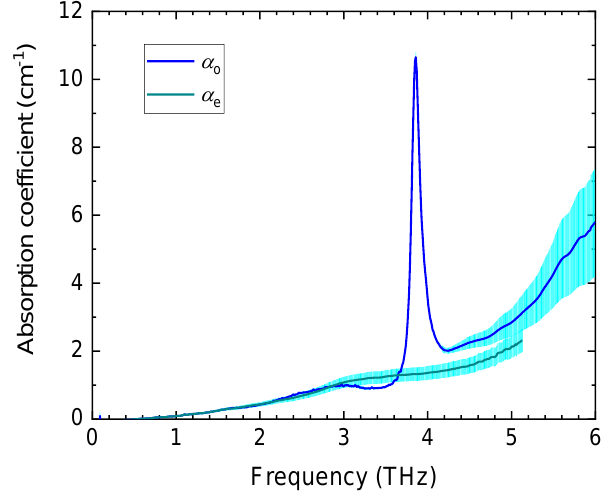
Figure 3. The ordinary ( α o ) and extraordinary ( α e ) absorption coefficients of quartz crystal. The uncertainties are shown by light blue shading. The optical phonon resonance in the ordinary spectrum is at 3.855 ± 0.005 THz.